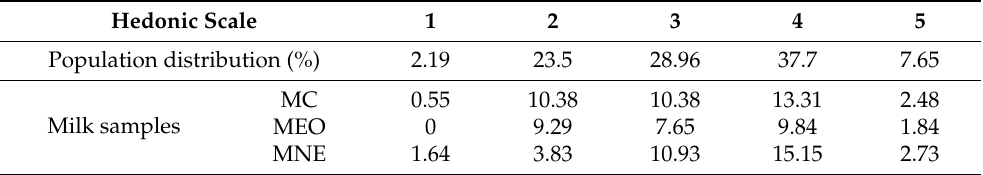
Figure 5. The general hedonic appreciation distribution of tested milk samples is based on their sensory attribute assessment (colour, aroma, taste, aftertaste, and texture). MC: Control milk, MEO: Milk enriched with bulk EO (1.5 mg/mL), MNE: Milk enriched with nanoemulsion (1.5 mg/mL). Table 5. The population distribution of general milk appreciation (expressed as % of the total population). MC: Control milk, MEO: Milk enriched with bulk EO, MNE: Milk enriched with